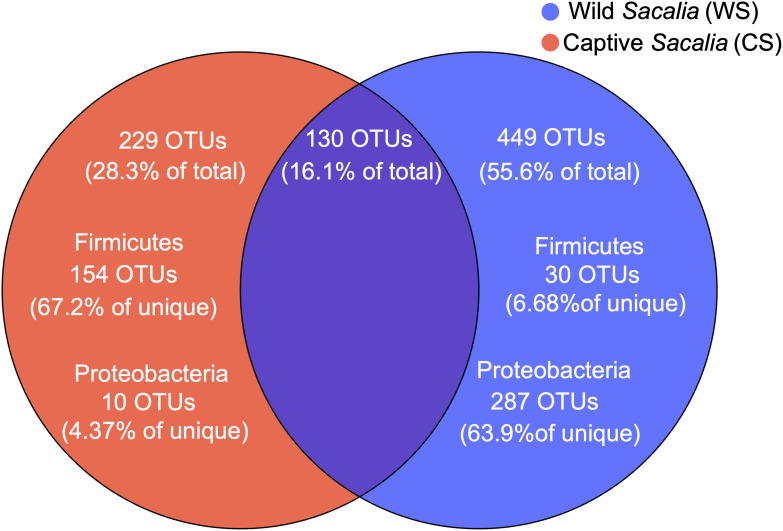
Venn diagram showing the unique and shared OTUs in wild (WS, blue) and captive (CS, red) Sacalia bealei. From the unique OTUs, a majority were Firmicutes (71.6%) for CS and a majority were Proteobacteria (63.9%) for WS.